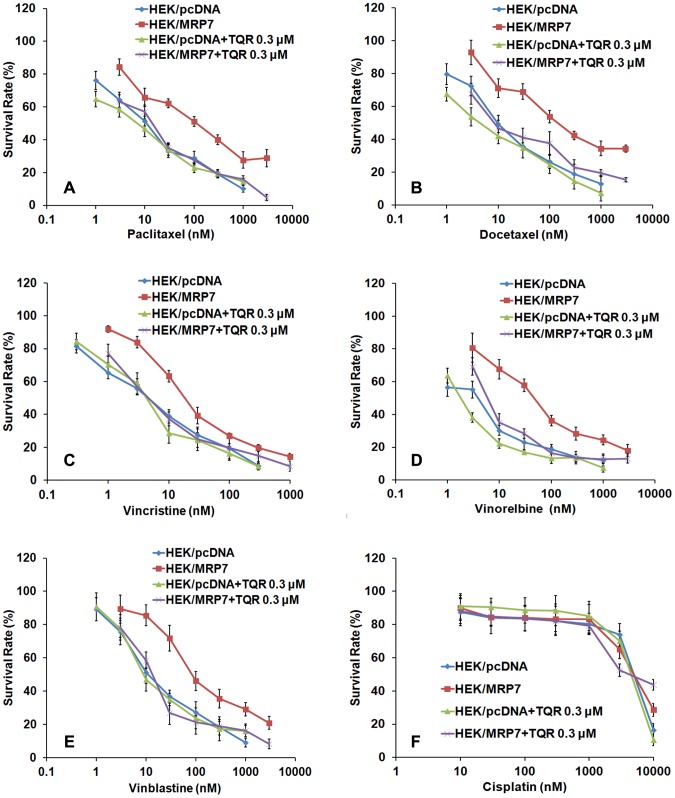
Effect of tariquidar on the sensitivity of HEK/pcDNA and HEK/MRP7 cells to anticancer drugs.HEK/pcDNA cells and HEK/MRP7 cells were cultured for 24 h before tariquidar was added. After 1 h incubation, paclitaxel (A), docetaxel (B), vincristine (C), vinorelbine (D), vinblastine (E), or cisplatin (F) was added, and the cultures were incubated for 72 h. Cell viability was measured by the MTT assay. Results were representative of 3 independent experiments.